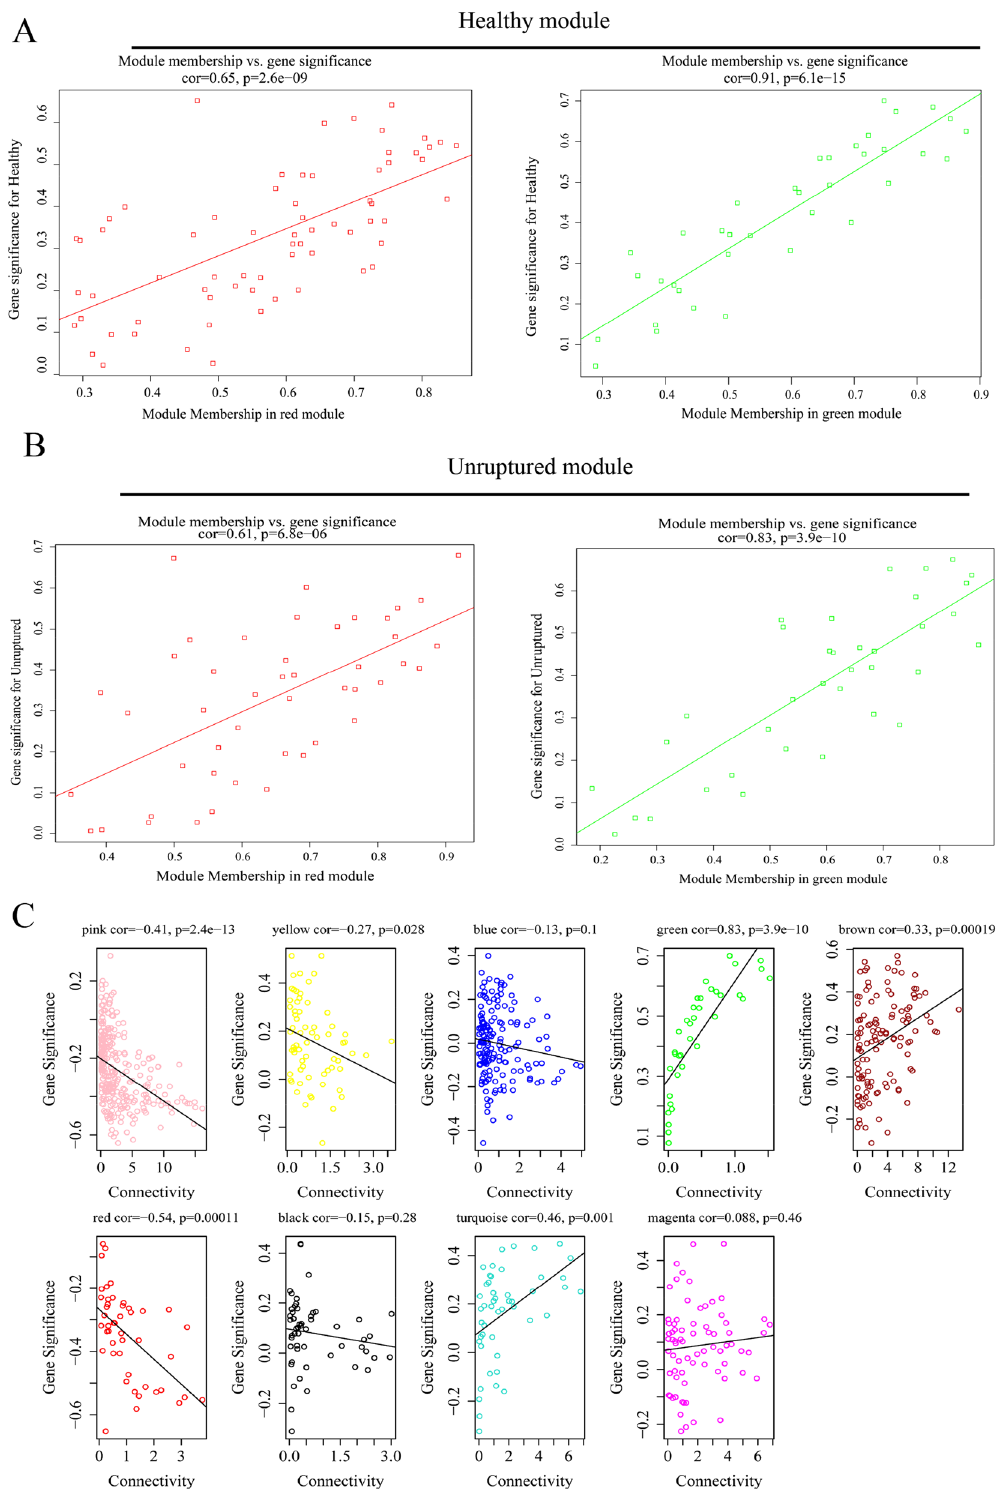
Figure 4. Correlation between traits (unruptured, healthy) and genes in the module and the gene internal connection degree. ( A, B ) Pearson’s correlation analysis of the correlation between traits (unruptured and healthy groups) and genes in the module. ( C ) The degree of gene connectivity in the top 9 color modules. Above all figures were visualized by R software